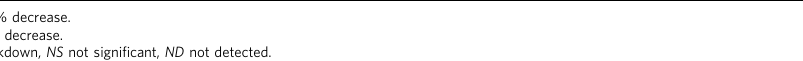
Table 1 Summary of effects on DPRs with eif-2D /eIF2D decrease.